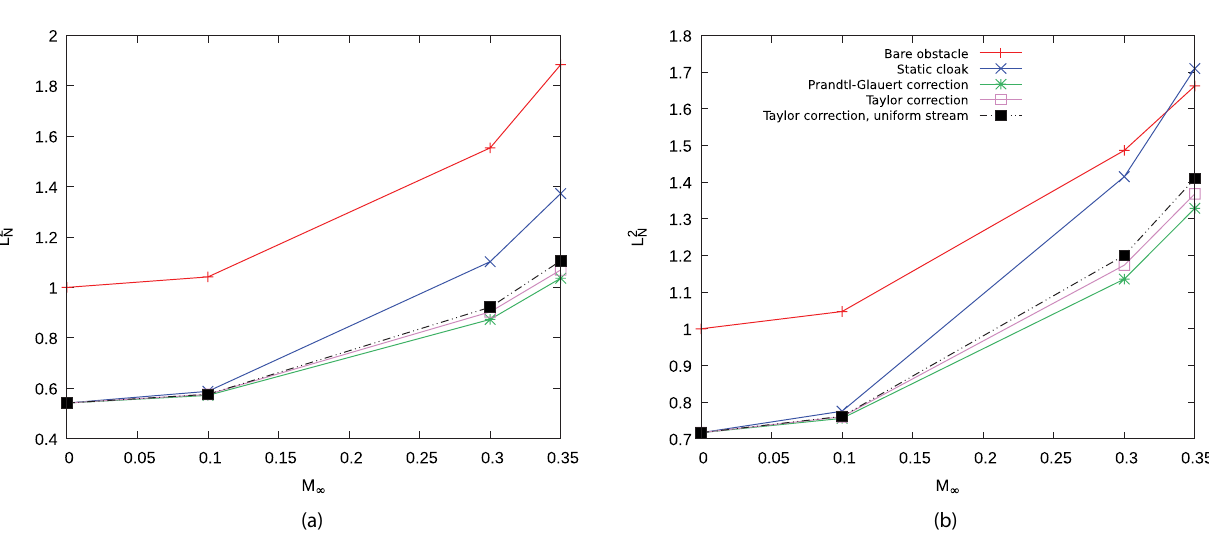
2 Figure 7. Normalized L -norm (Eq. (17)) as a function of M of the bare obstacle is compared with those calculated for the cloaked object. Static cloak is depicted by blue marks, whereas pink, black and green marks refer to (cid:31) T , (cid:31) TUS , and (cid:31) PG ,